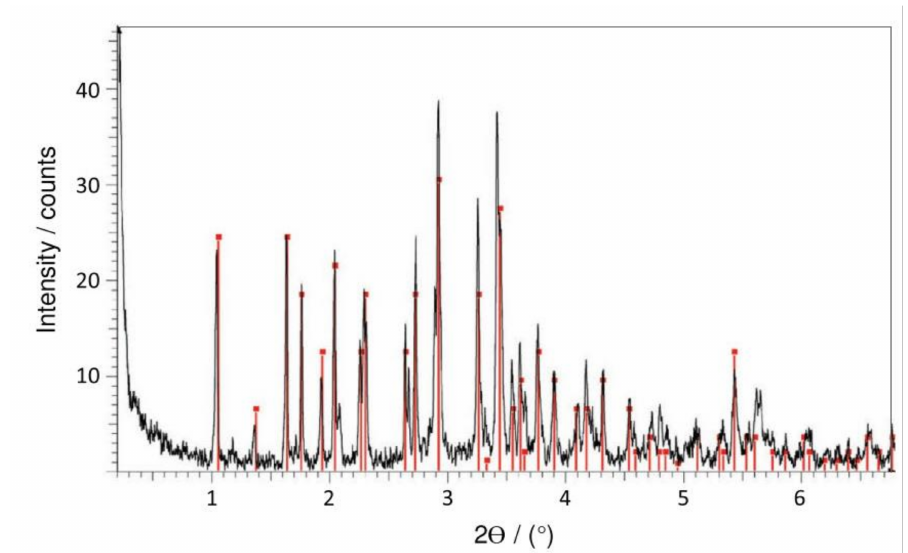
Figure 24. X-ray diffraction (XRD) pattern of the patina of sodium monofluorophosphate (Na 2 PO 3 F, MFP), showing canaphite (Na 2 CaP 2 O 7 · 4H 2 O) phase represented by red peaks [43]. Reproduced with permission from Bastidas, D.M. et al., Cem. Conc. Comp.; published by Elsevier, 2013.